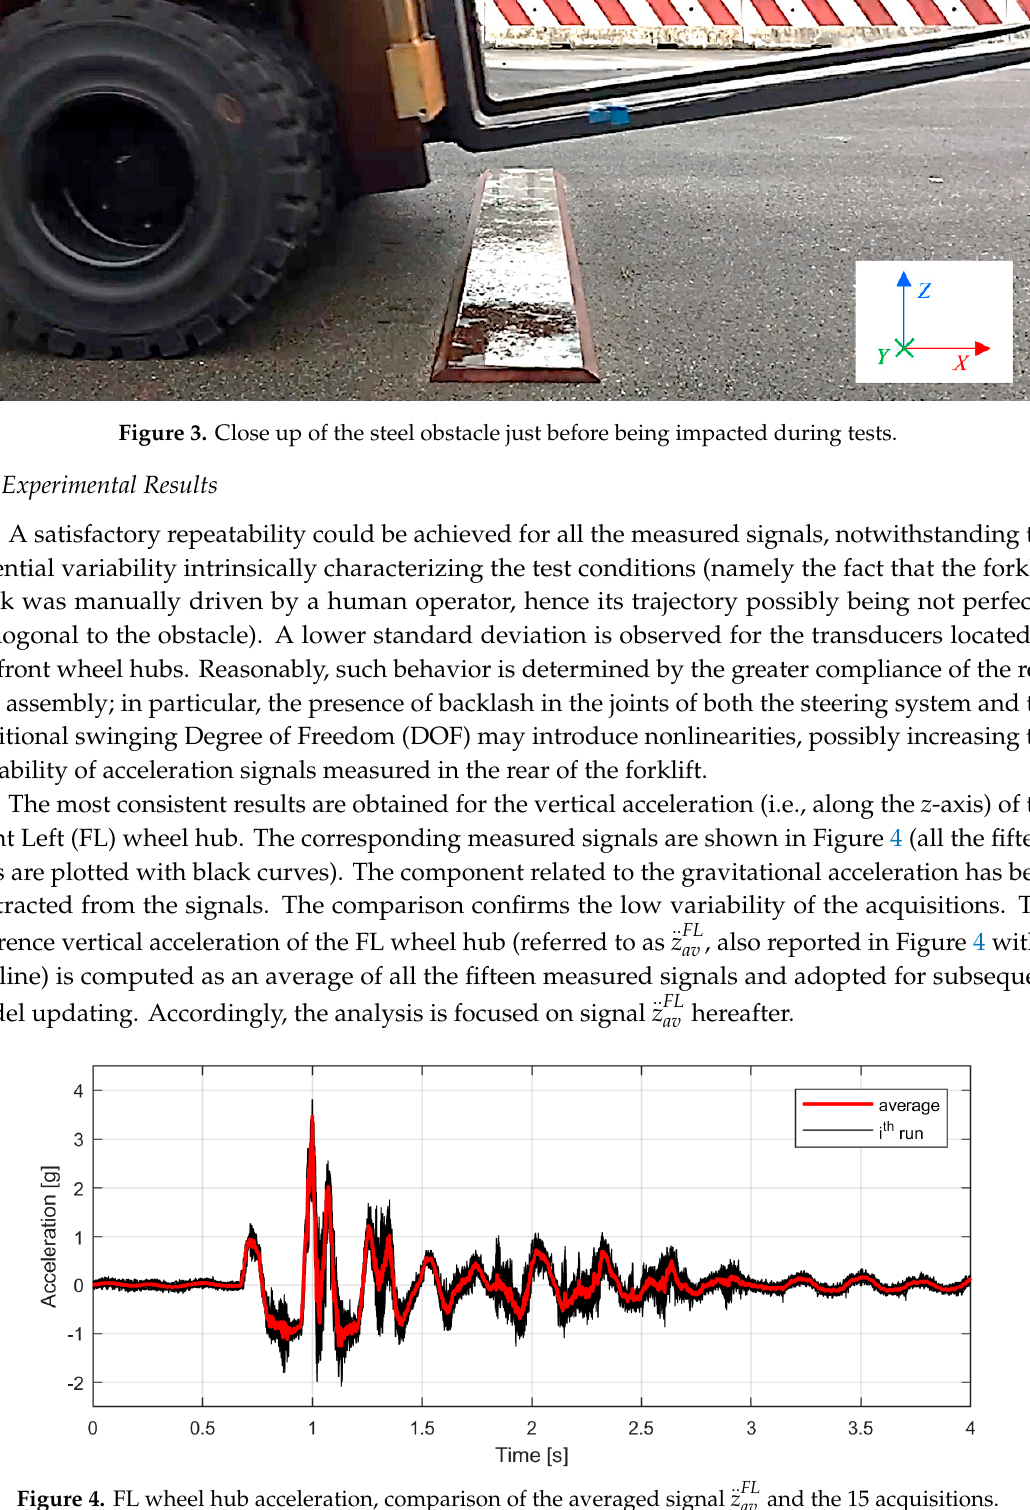
Figure 4. FL wheel hub acceleration, comparison of the averaged signal